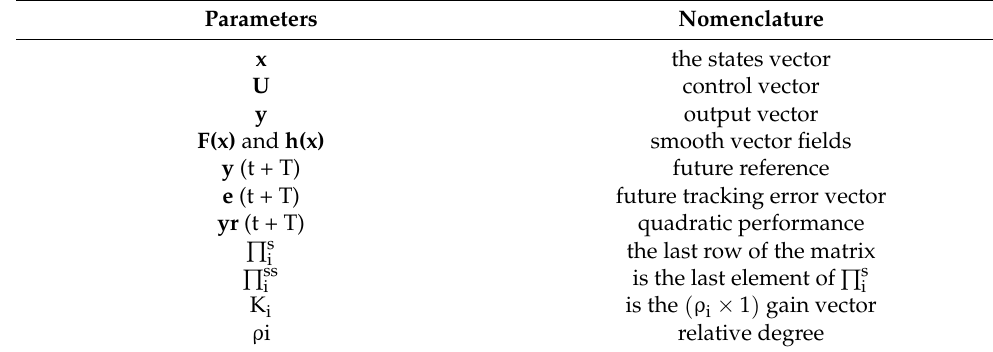
Table 2. Nomenclature of the multiple input–multiple output (MIMO) system parameters